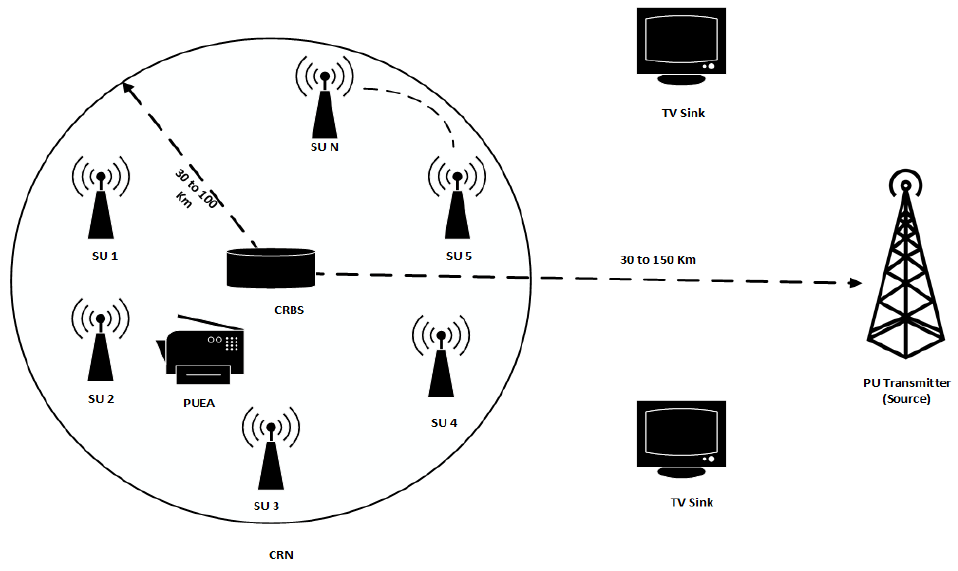
Figure 1. System design.